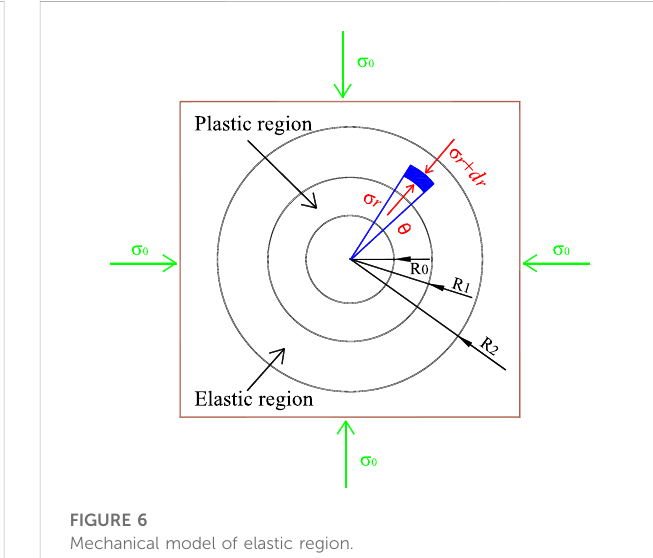
FIGURE 6 Mechanical model of elastic